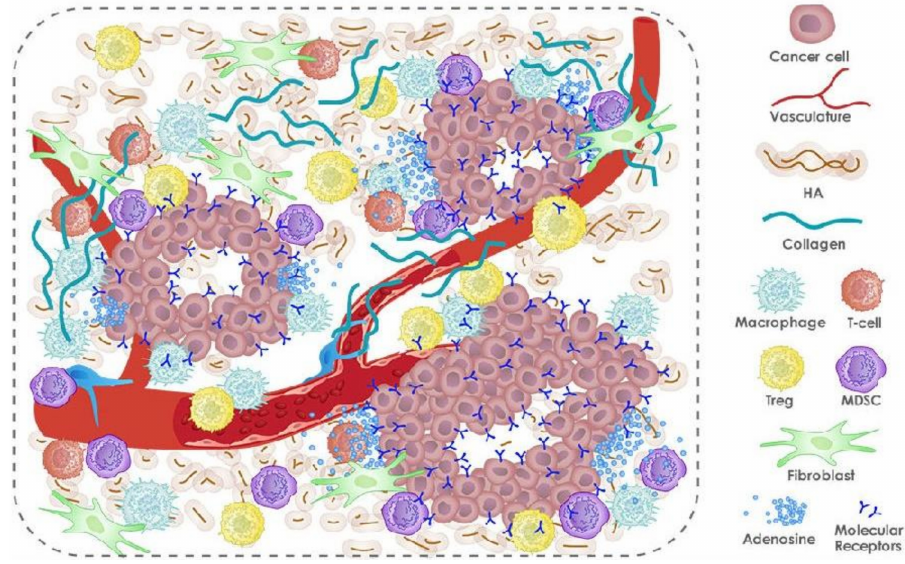
Figure 2. Tumor microenvironment. HA—hyaluronic acid; MDSC—myeloid-derived suppressive